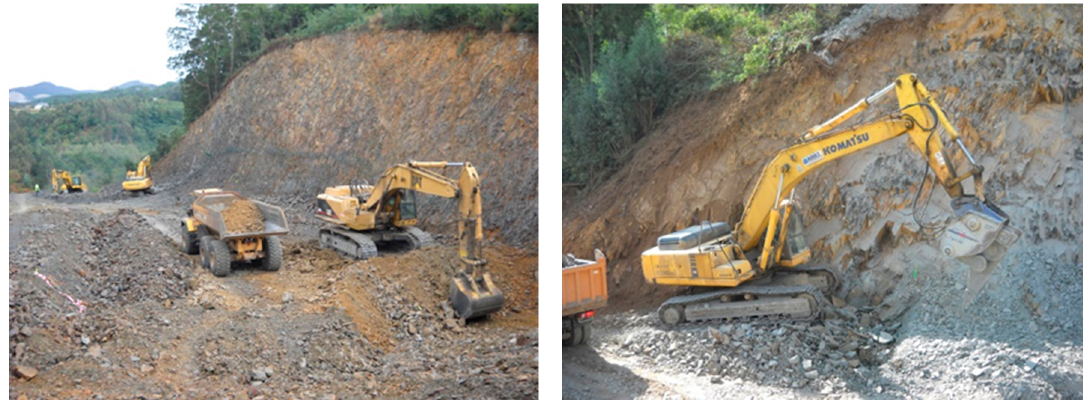
Figure 9. Machinery working in the trench.